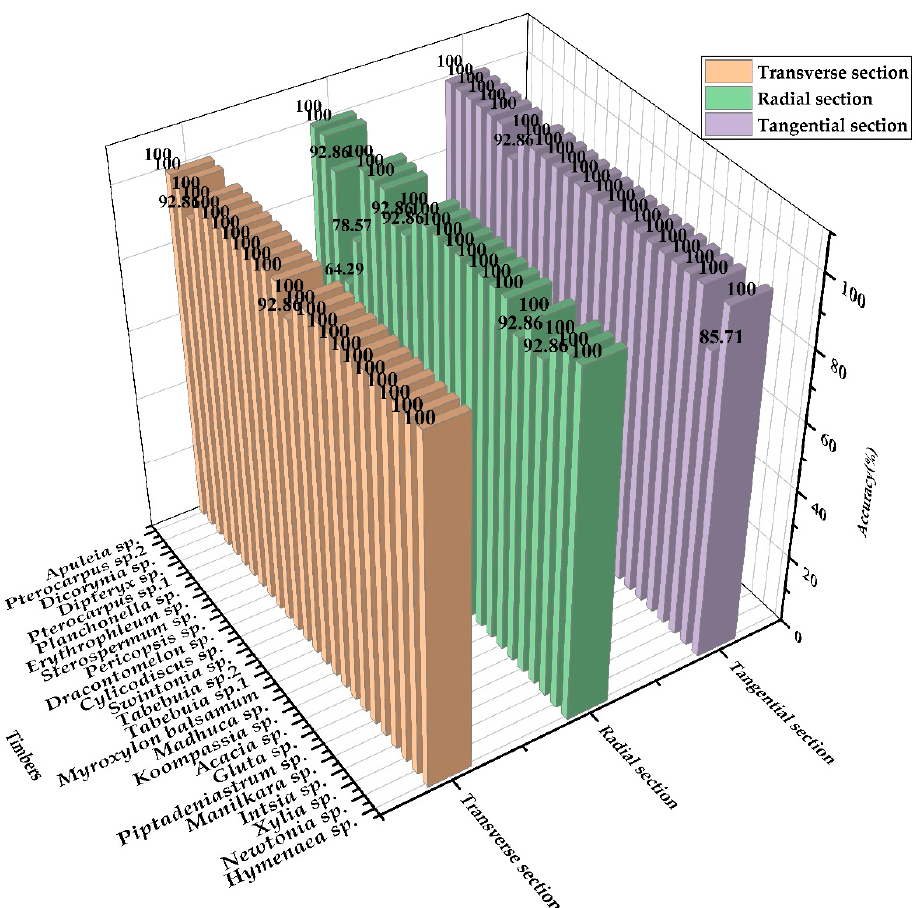
Figure 4. Identification accuracy of the 25 timbers based on the combined information of the 3 sectional surfaces. Table 5. Identification accuracy of the SVM model based on two short NIR bands combined with GLCM features.